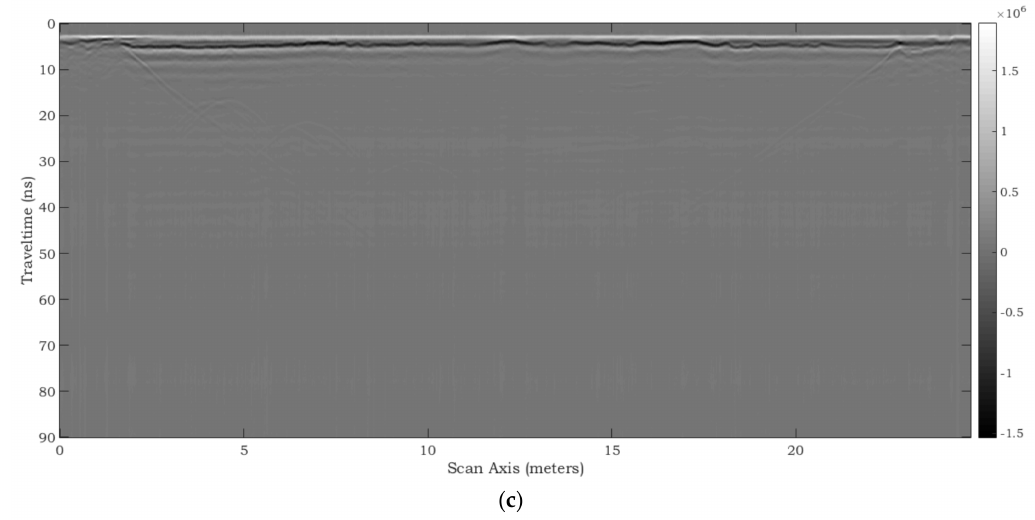
Figure 33. Profiles recorded in the Gneiss 14/20 gravel region by using GPR 1, on acquisition line 2, with last-generation antennas operating at: ( a ) 400 MHz; ( b ) 500 MHz; ( c ) 900 MHz.